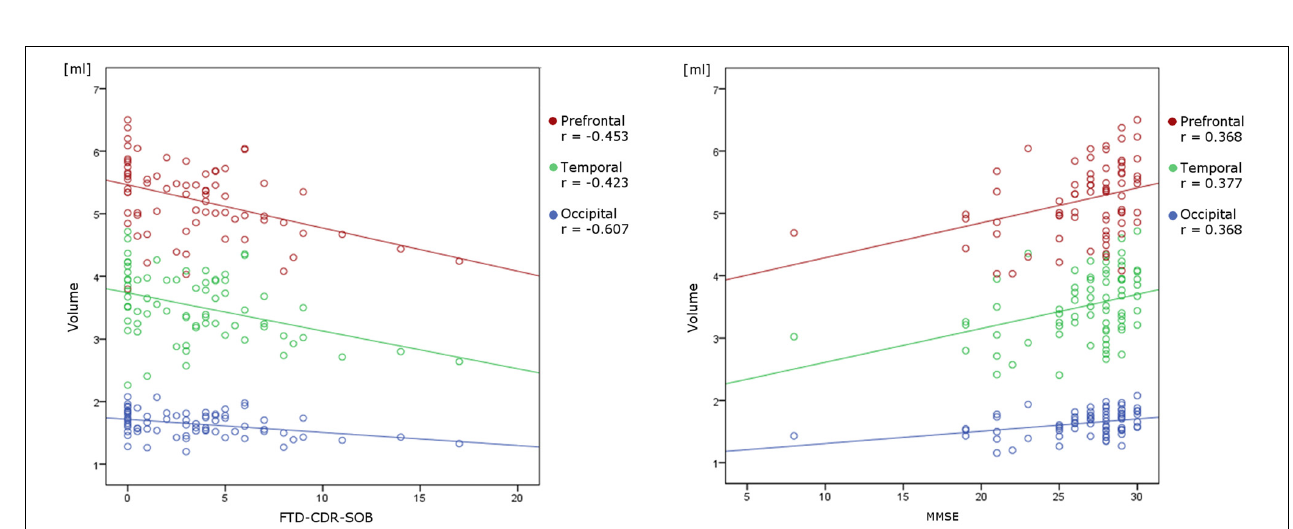
FIGURE 3 | Linear correlation between volumetric data and neuropsychological variables. There is a significant negative/positive correlation of FTD-CDR-SOB/MMSE with the volumes of the prefrontal, temporal and occipital subregion of the thalamus.